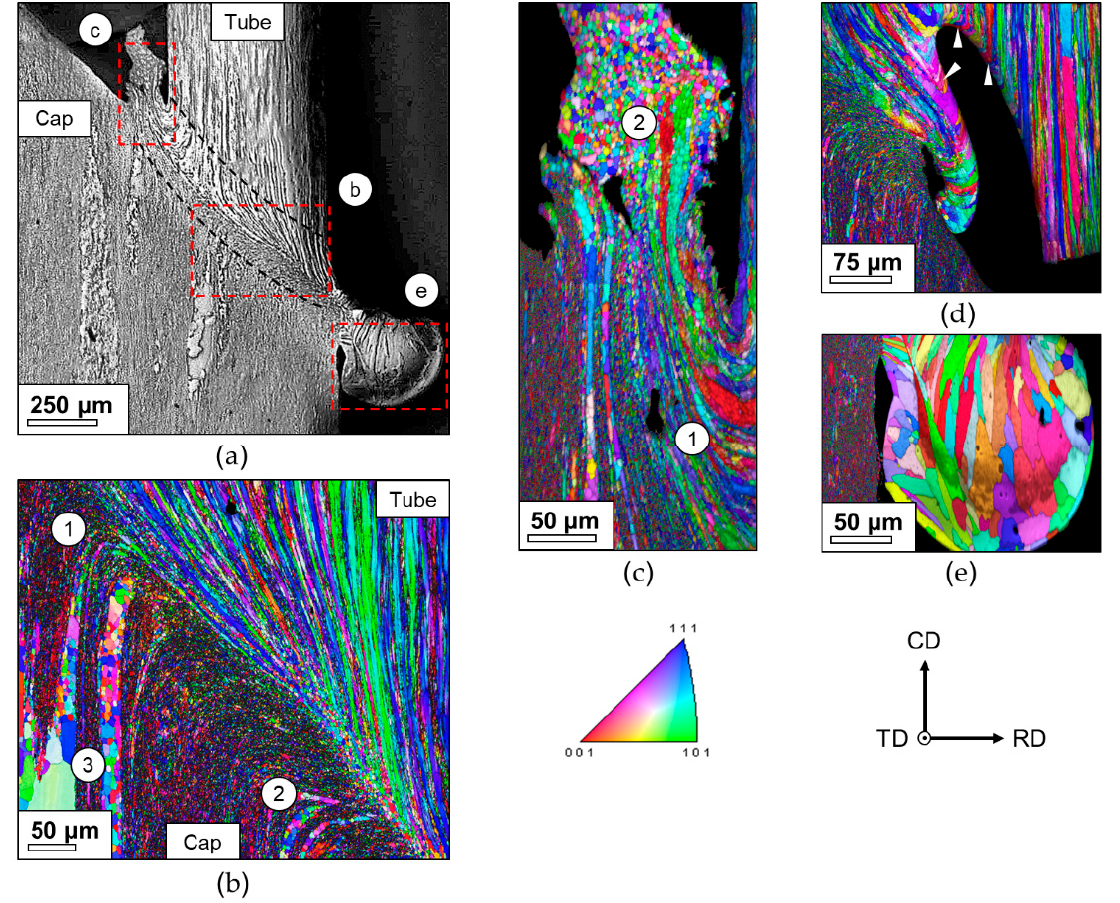
Figure 2. ( a ) Light optical microscopy photograph of a 14YWT tube and cap joined using CDRW with Weld Condition 3. Black dashed lines highlight the rough extent of TMAZs, whereas red dashed boxes highlight the sites of EBSD scans shown in ( b , c , e ). ( b ) Grain orientation map (relative to TD) showing component textures warping toward the weld line. Highlights 1 and 2 mark especially clear bending of grain groups in the cap TMAZ, whereas highlight 3 indicates an example of enlarged cap grains caused by the heterogeneity of hot extrusion—rather than CDRW with dashed lines added to highlight TMAZs. ( c – e ) Grain orientation maps (relative to TD) from grain recrystallization and coarsening defects in the expulsion regions of CDRW joints. Here, ( d ) comes from a joint produced at Weld Condition 1.